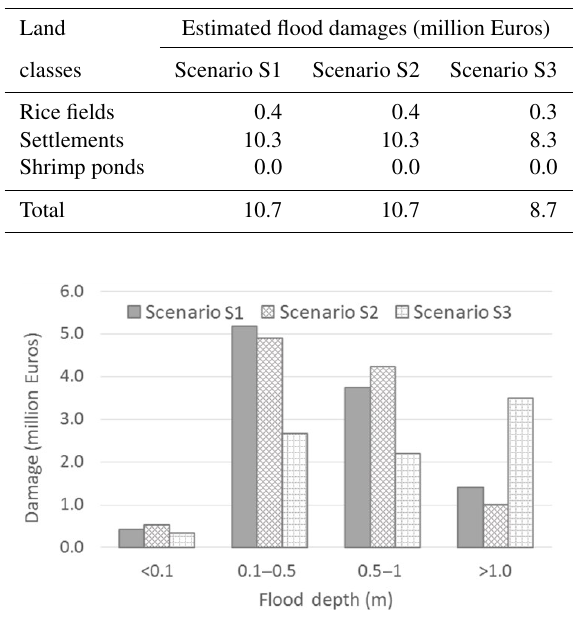
Figure 11. Variation of estimated flood damages with varying ranges of flood depths corresponding to Scenario S1, S2 and